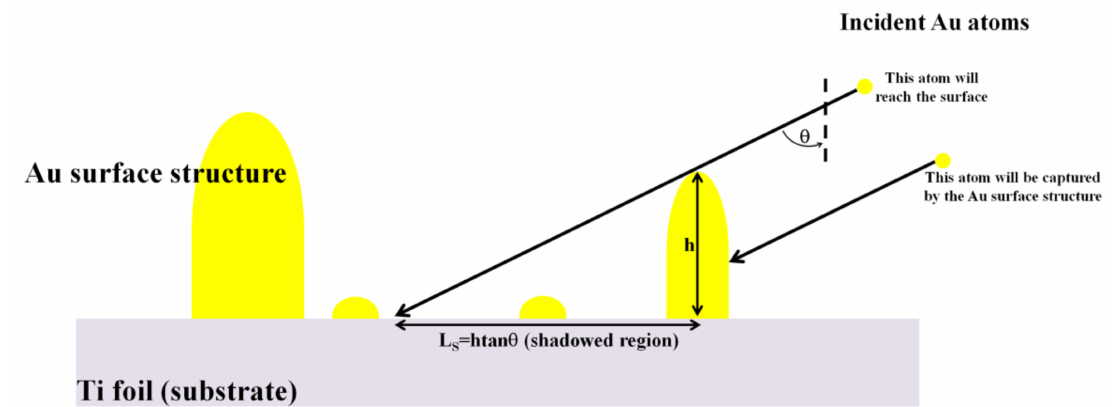
Figure 6. Schematic picture illustrating the shadowing effect during the Au atoms deposition in the oblique condition and in the late state of the deposition process, when high Au surface structure are formed on the substrate surface. h is the characteristic height of these surface structures, θ the atoms deposition angle (angle for which the atoms from the vapor-phase arrive on the substrate surface), and L S the resulting shadowing